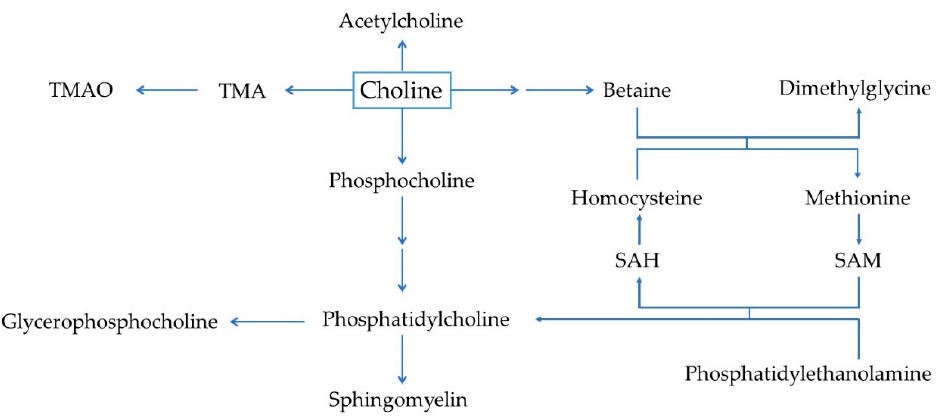
Figure 2. Simplified overview of choline metabolism. Abbreviations: SAM, S -adenosylmethionine; SAH, S -adenosylhomocysteine; TMA, trimethylamine; TMAO, trimethylamine- N -oxide.